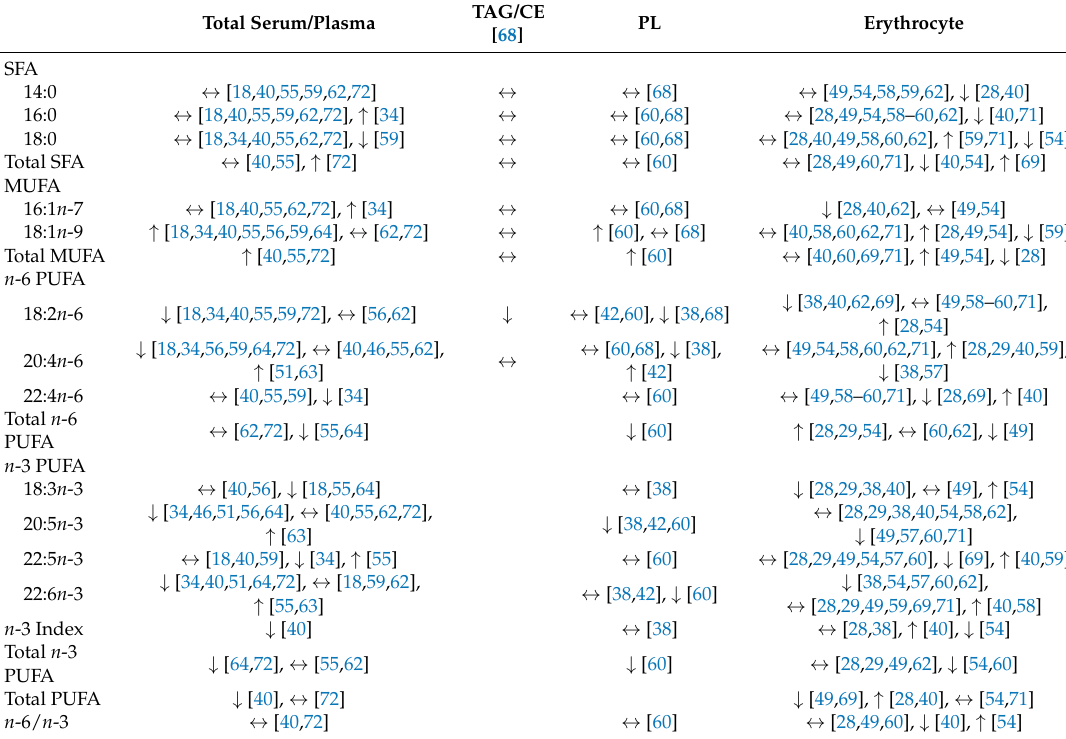
Table 3. Comparison of FA status of dialysis patients to healthy